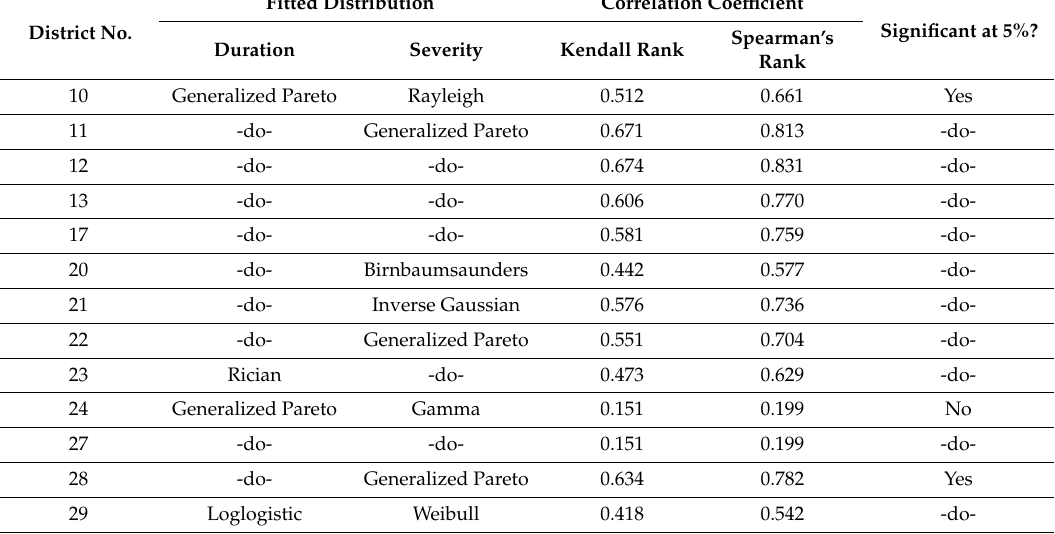
Table 3. Best probability distributions in modelling marginal drought duration and severity computed from SPI-12 time series.